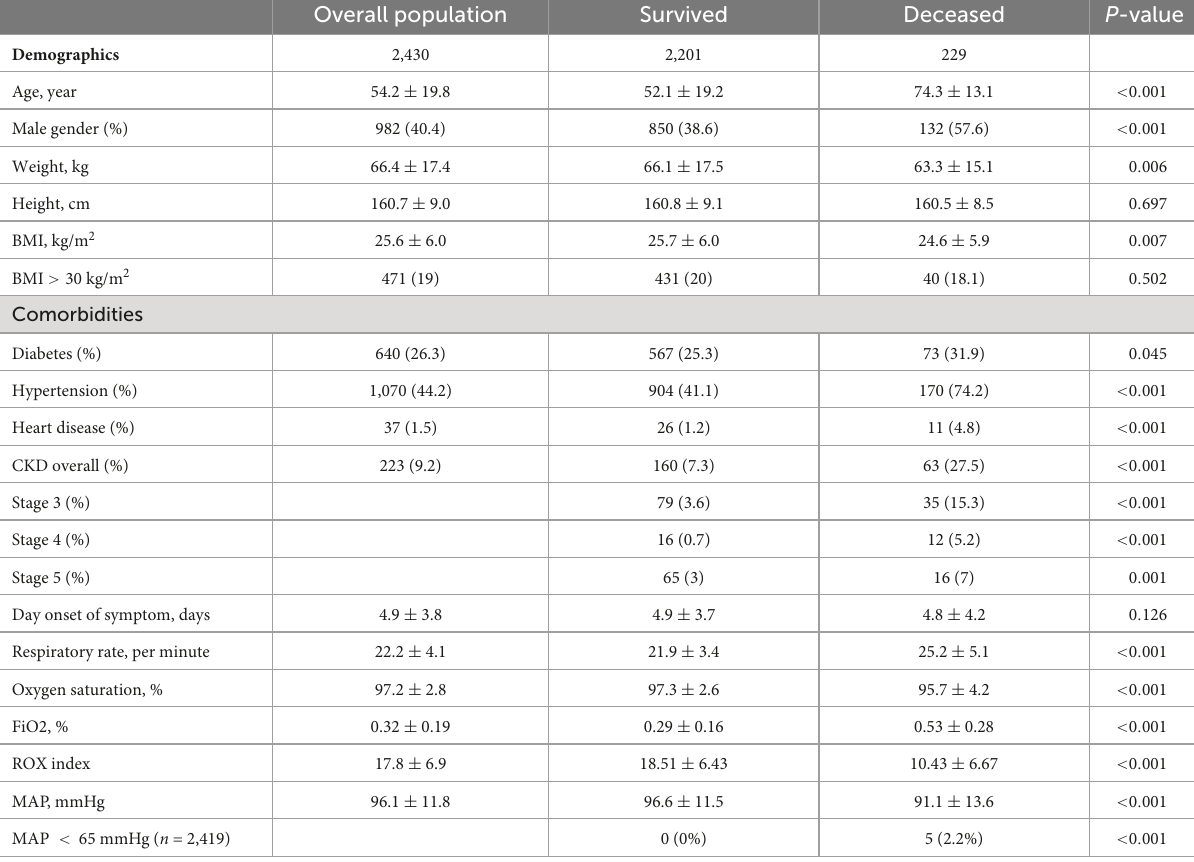
TABLE 1 Baseline characteristic within 24 h of hospital admission according to hospital